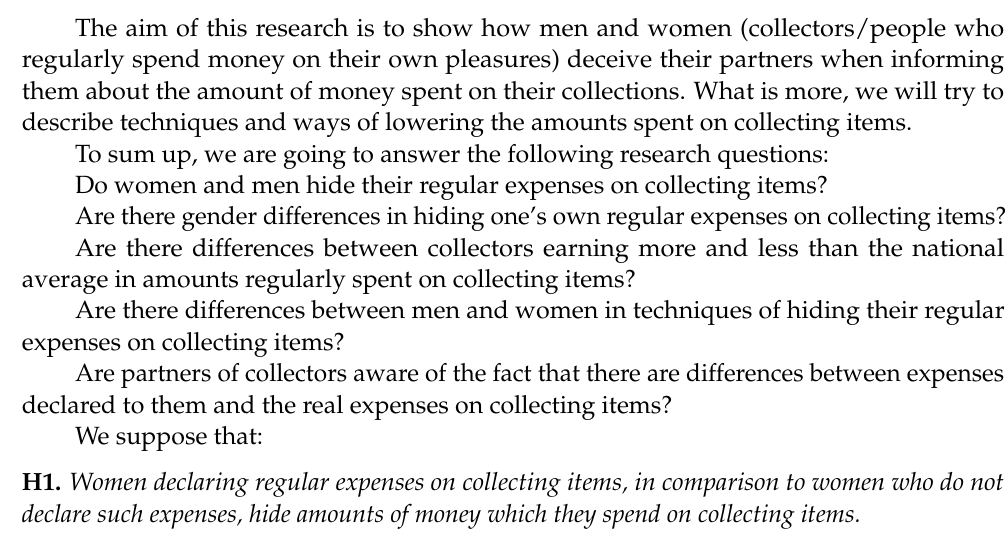
Figure 4. At last, somebody thought of a way to sell something more to